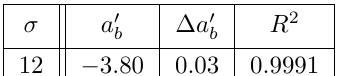
is the uncertainty of parameter b